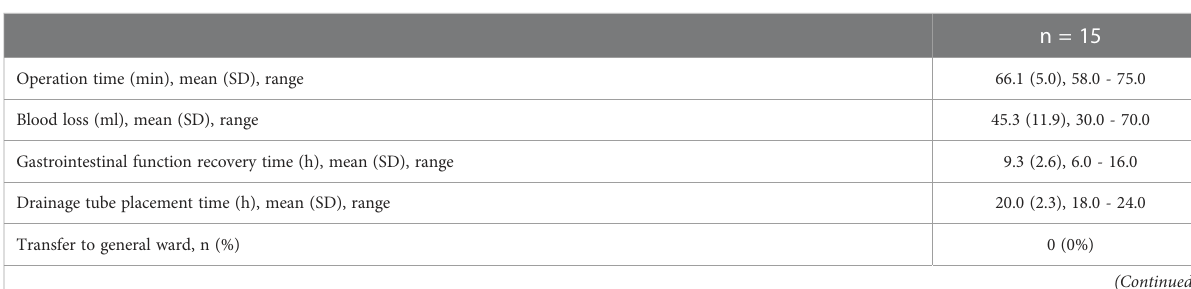
TABLE 4 Intraoperative and postoperative